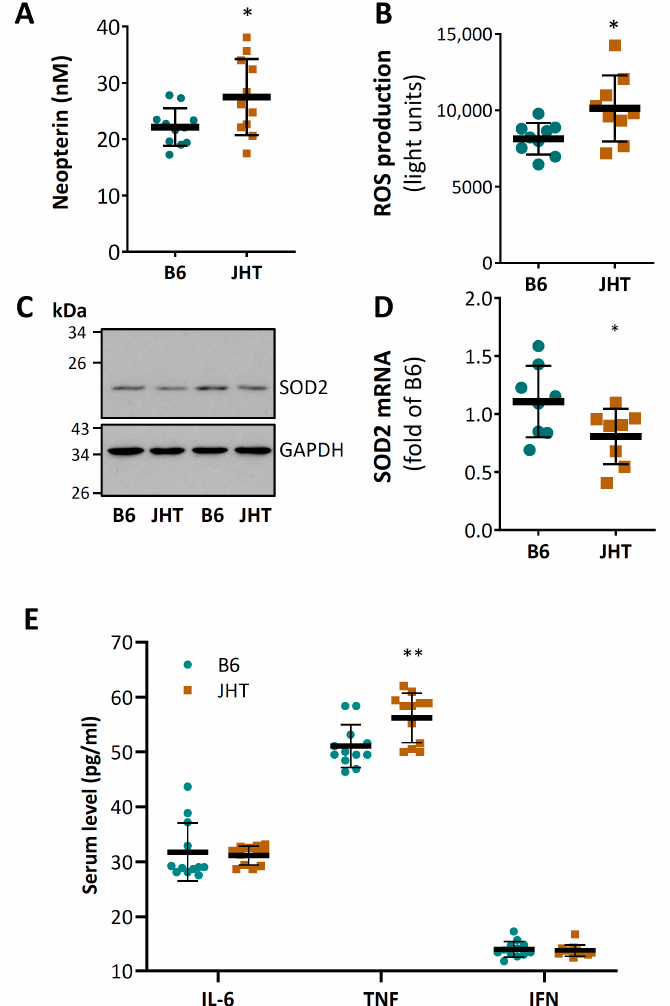
Figure 2. B cell-deficiency in mice leads to vascular oxidative stress and inflammation. Neopterin concentration in blood of 17-week-old mice was measured with HPLC ( A ). Aortic ROS production was determined with L-012 chemiluminescence ( B ). SOD2 protein expression ( C ) was analyzed with Western blotting. mRNA expression was studied by qPCR using aorta samples ( D ). The horizontal lines in the scatter dot plots ( A , B , D , E ) represent mean ± SD. * p < 0.05, ** p < 0.01, compared with wild-type mice (B6); unpaired t